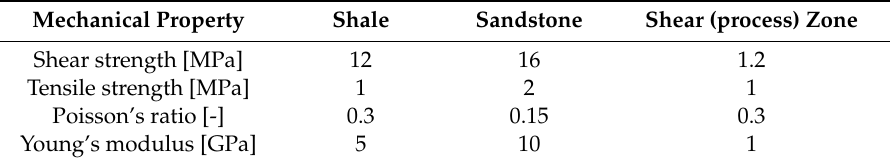
Table 1. Mechanical properties in the simulation domain for the depletion case with fracturing. Mechanical Property Shale Sandstone